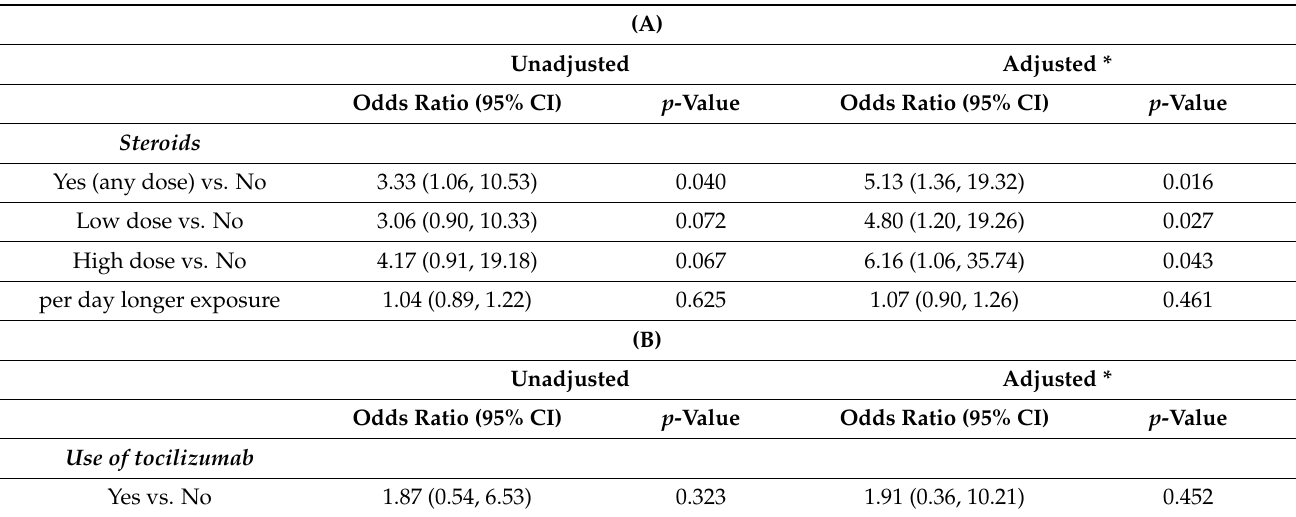
Table 2. Logistic regression estimates of the risk of HSV-1